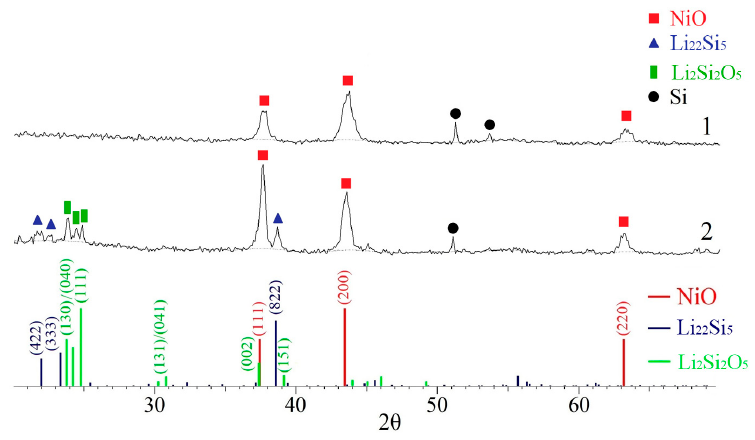
Figure 6. Grazing incidence XRD patterns of (1) LNO-M and (2) LNO-M-800 samples.